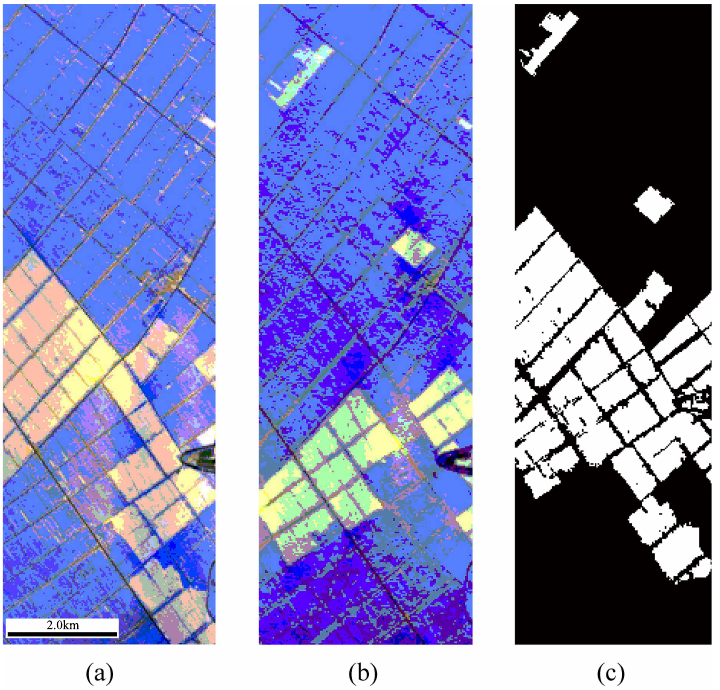
Figure 7. Wetland Agriculture Dataset with false color map (Bands 134, 90, and 75 as RGB). ( a ) Chinese farmland image captured on 3 May 2006. ( b ) Chinese farmland image captured on 23 April 2007. ( c ) Binary ground truth for the Wetland Agriculture